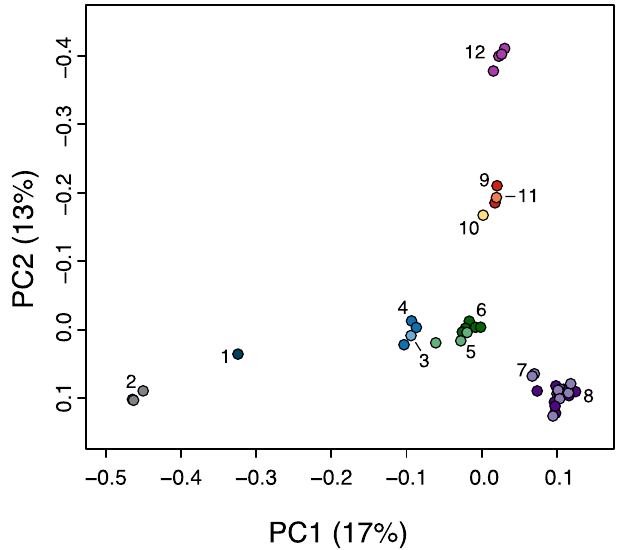
Figure 2. Principal component analysis of the Iberian desman individuals. Each locality is represented with a different color. The locality code, which can be found in the legend of Fig. 1, is also